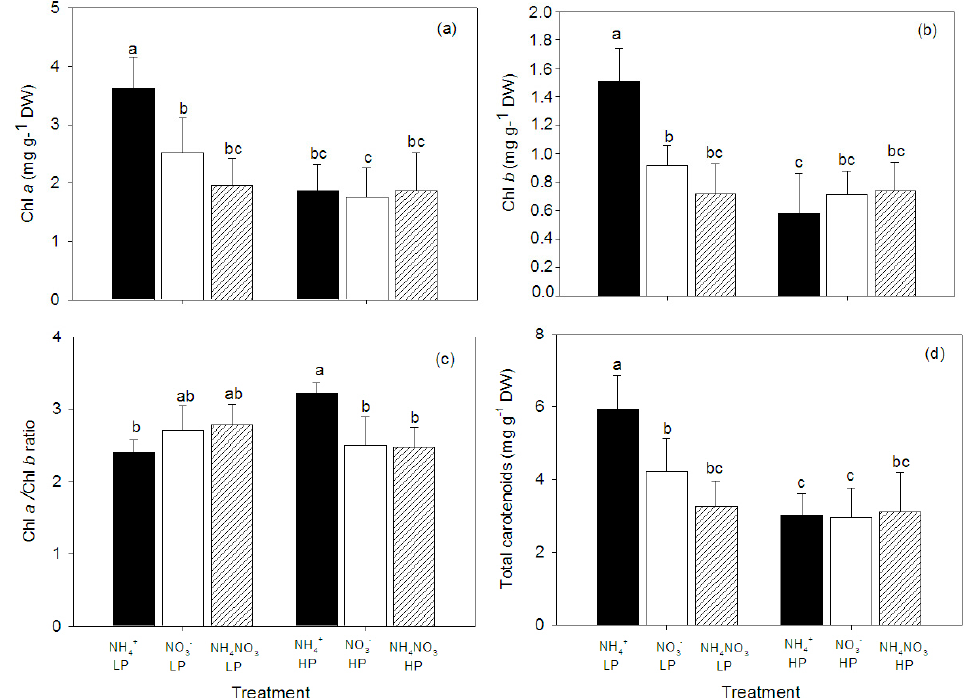
Figure 3. Chlorophyll a , Chl a ( a ); chlorophyll b , Chl b ( b ); Chl a/Chl b ratio ( c ); and total carotenoids ( d ) in leaves of hybrid Napier grass ( Pennisetum purpureum × P. americanum ) (mean ± SD) grown on different N forms (NH 4+ , NO 3 − , and NH 4 NO 3 ) and P concentrations (LP, low P concentration (100 µM